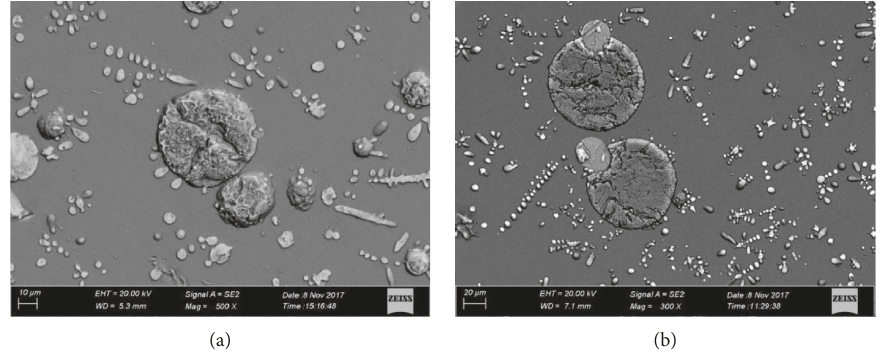
Figure 7: High-magnification microstructure of Cu-15 wt.% Fe at different undercooling states: (a) ∆ T � 102K; (b) ∆ T �